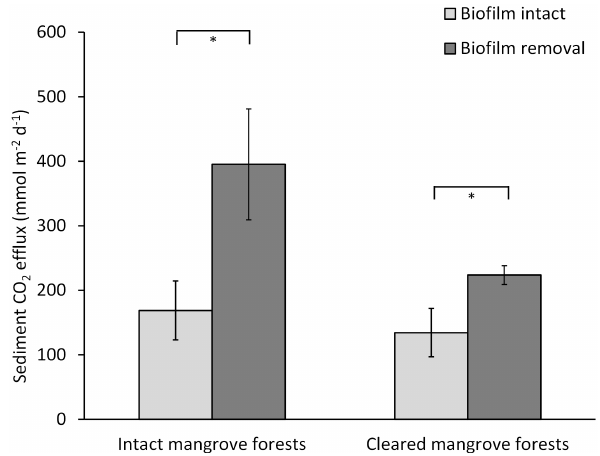
Figure 3. Mean sediment ( ± SE) CO 2 efflux (mmolm − 2 d − 1 ) be- fore and after surface biofilm removal, from intact mangrove forest (13 sites), and cleared mangrove forest (23 sites). ∗ Significant dif- ference ( p